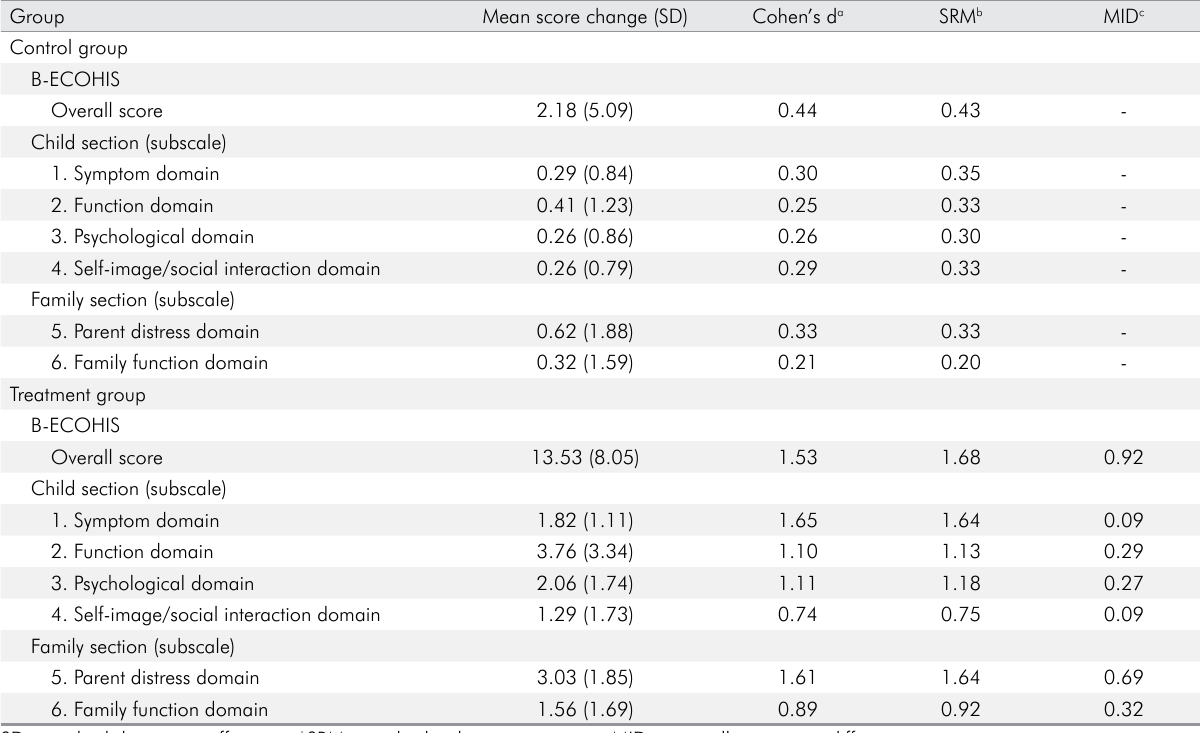
Table 5. Sensitivity and responsiveness of the B-ECOHIS to caries